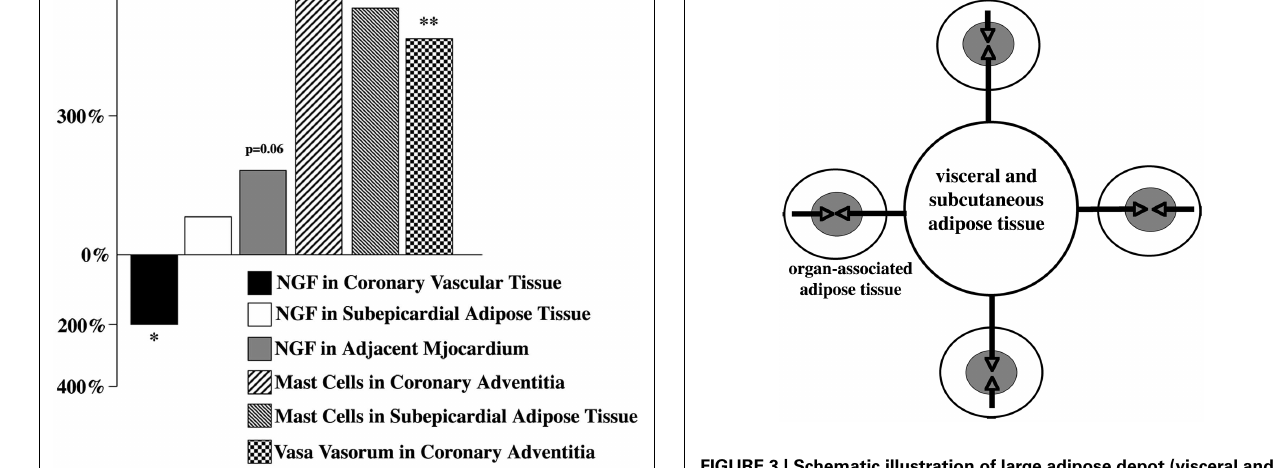
FIGURE 3 | Schematic illustration of large adipose depot (visceral and subcutaneous adipose tissue) and small adipose depots (organ- associated adipose tissue) . Dual action of adipokines, via endocrine pathway (long arrows) and via paracrine pathway (short arrows) on the adipose tissue-associated organs, is depicted. Modified from Ref.